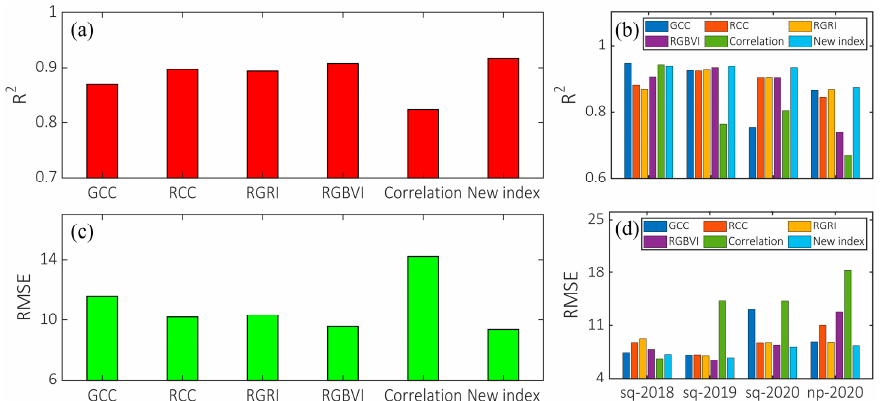
Figure 7. Comparison of extracted and observed phenology from ground observation of maize using different indices. ( a , c ) represented the R 2 and RMSE using different indices for all sites and years, ( b , d ) represented the R 2 and RMSE using different indices for different sites and years, respectively.